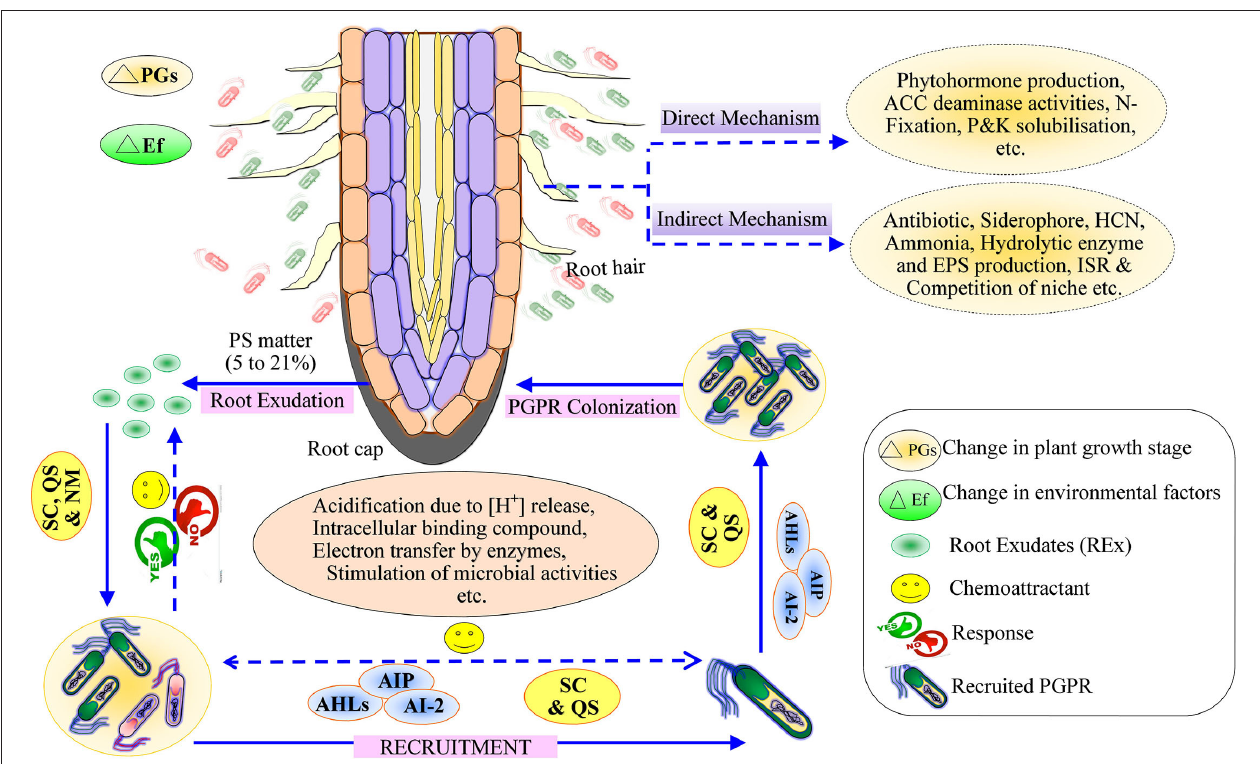
FIGURE 1 | Schematic representation of the mechanism of root exudates for recruitment of plant growth-promoting rhizobacteria and plant growth-promoting mechanism (Direct and Indirect). SC, Selected compounds; QS, quorum sensing; NM, Nutrient management; AHL, Acyl Homoserine lactone; AIP, Autoinducing peptides; AI-2, Autoinducer; PS, Photosynthetic